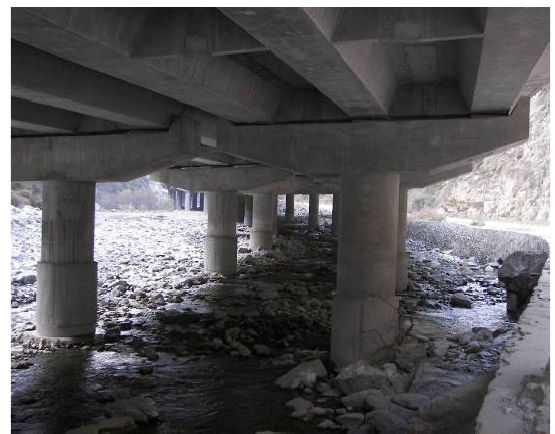
Figure 1. Longitudinal bridge piers in valleys.